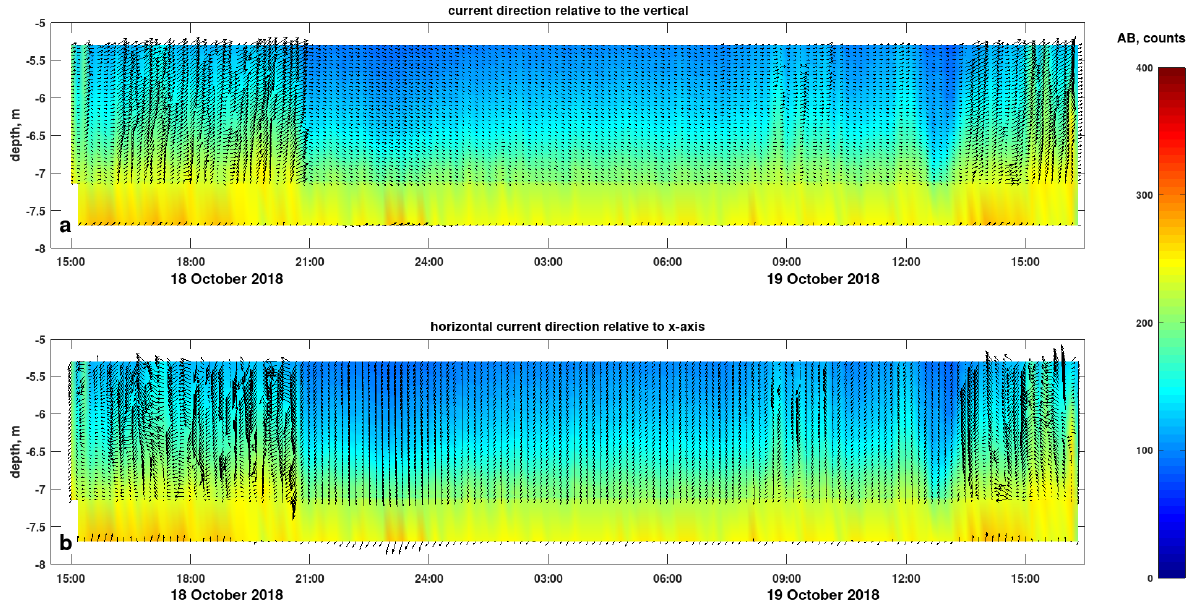
Figure 4. ( a ) Current vertical direction superposed over acoustic back-scatter. The x- and y-axis com- ponents of the displayed vectors are proportional to the horizontal and vertical velocity components, respectively. ( b ) Similarly to ( a ), however, the x- and y-axis components of the displayed vectors correspond to the x- and y-axis horizontal components of the flow, thus near-bed vectors pointing to the right suggest flow toward the Aquadopp profiler.